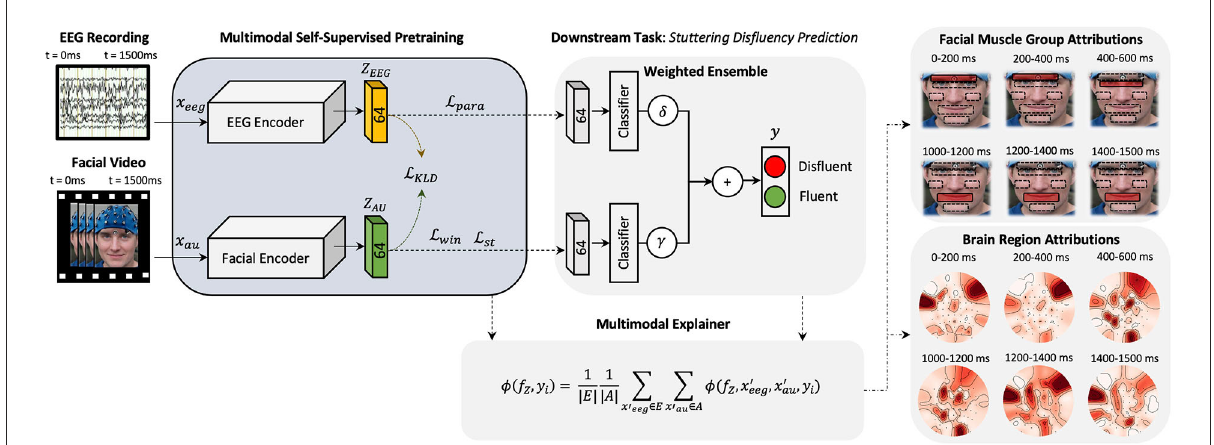
FIGURE1 A high-level architecture of the proposed explainable multimodal self-supervised approach is presented. Two CNN models are pre-trained with self-supervision and latent space combined to form a multimodal architecture for feature-wise ensemble fusion. Multimodal explanations are generated (one explanation map for each input) using the proposed multimodal shapley explanation method and the highest attributing features are